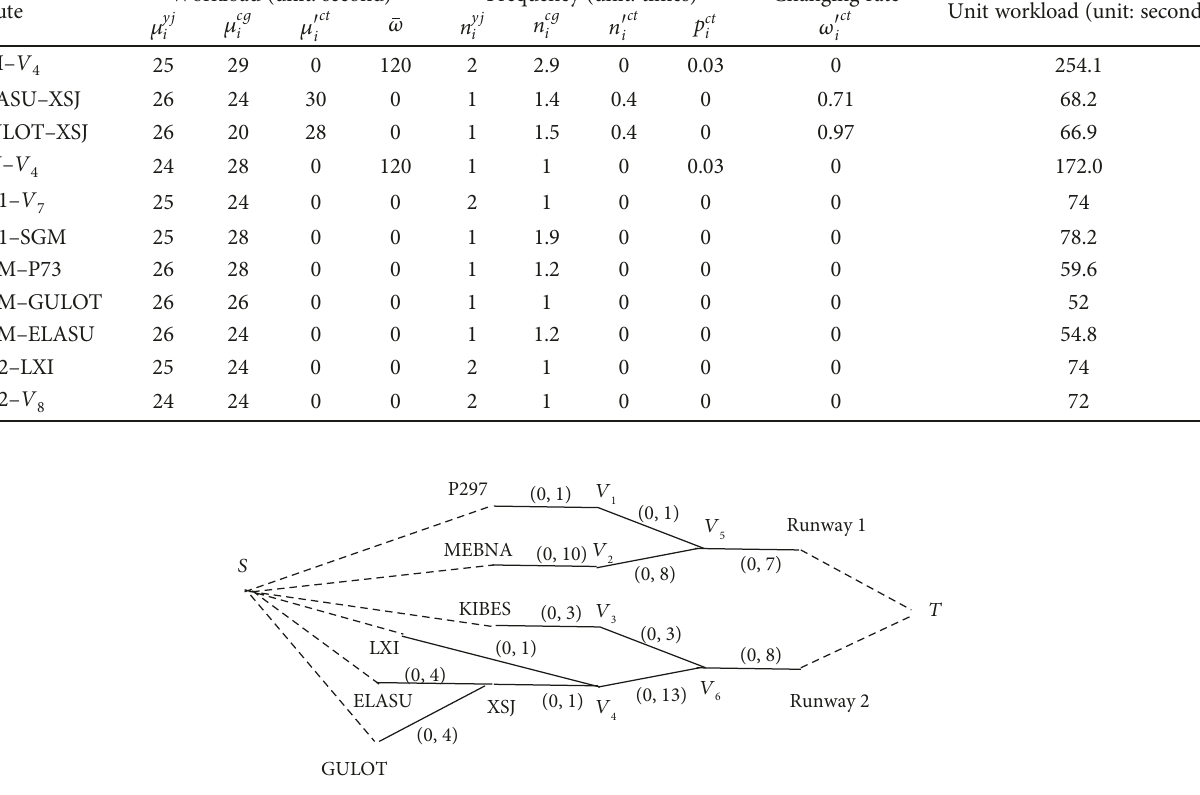
Figure 10: Arrival route network with capacity under the meteorological in fl uence (b).